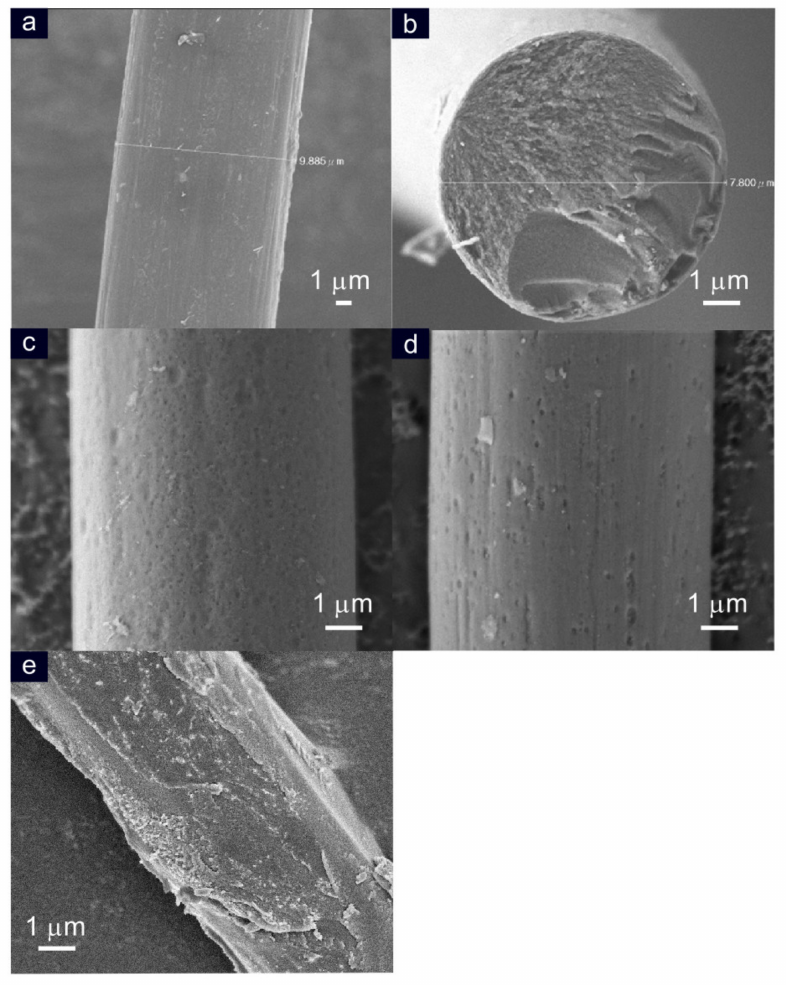
Figure 5. SEM morphology of carbon fiber before ( a ) and after the electro-exfoliated process per- formed in ( b ) 0.1 M of H 3 PO 4 , ( c ) 0.1 M PBS (pH = 7), ( d ) 0.01 M of NaOH, and ( e ) 0.01 M of NaOH + 0.1 M of PO 4 3 −